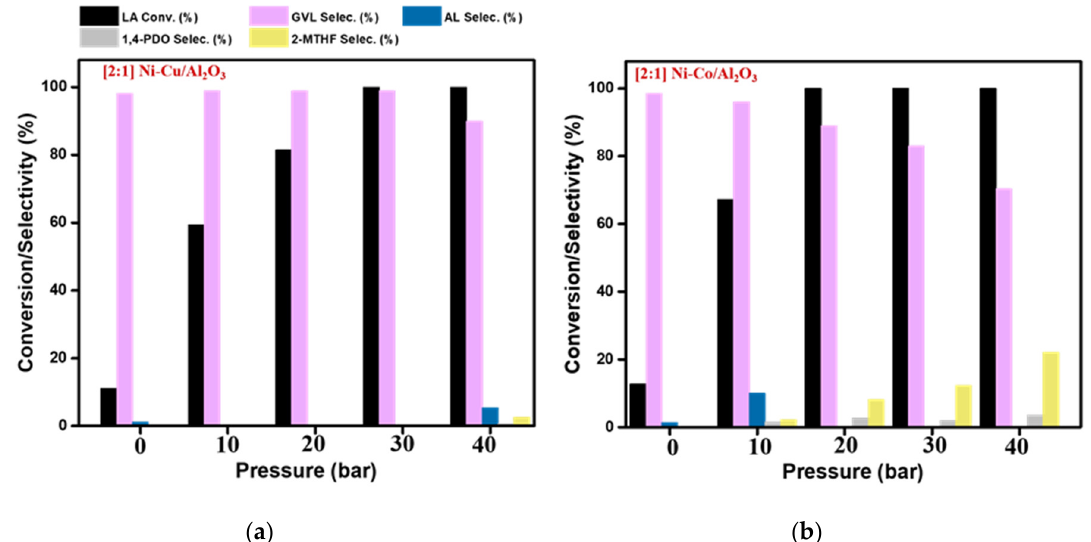
Figure 10. The reaction results for the effect of reaction pressure over ( a ) [2:1] Ni-Cu/Al 2 O 3 and ( b ) [2:1] Ni-Co/Al 2 O 3 on the hydrogenation of LA. Reaction conditions: 20mL LA, 1 g catalyst, 220 ºC, and 6 h reaction time.